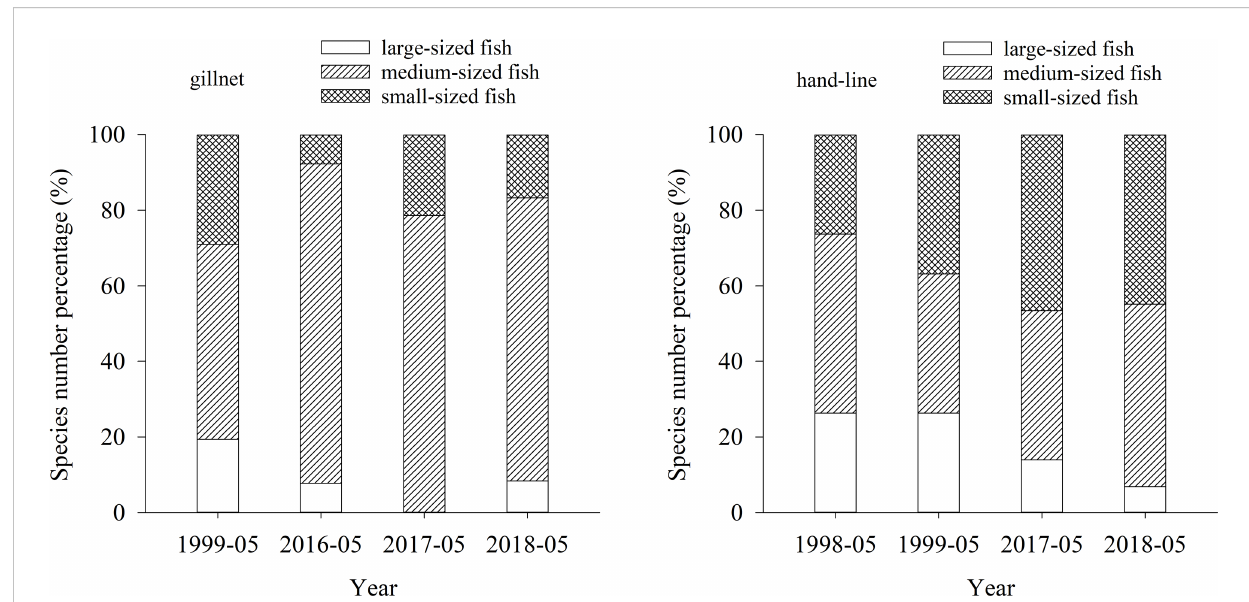
while the percentages in 2016 — 2018 were all zero (Figure 9). Results of linear regression indicated that coral cover had the greater effect on the percentages of species number and weight of hb fi sh as compare to fi shing power (Figure 9; Table 4). In addition, results of linear regression indicated that coral cover had the greater effect on the weight percentage of very high & high-value fi sh as compare to fi shing power in gillnet surveys (Figure 10; Table 5). The effect of coral cover on weight percentage of very high & high-value fi sh was more pronounced in gillnet surveys than in hand-line survey. Both fi shing power and coral cover had signi fi cant effects on the mean body weight of high